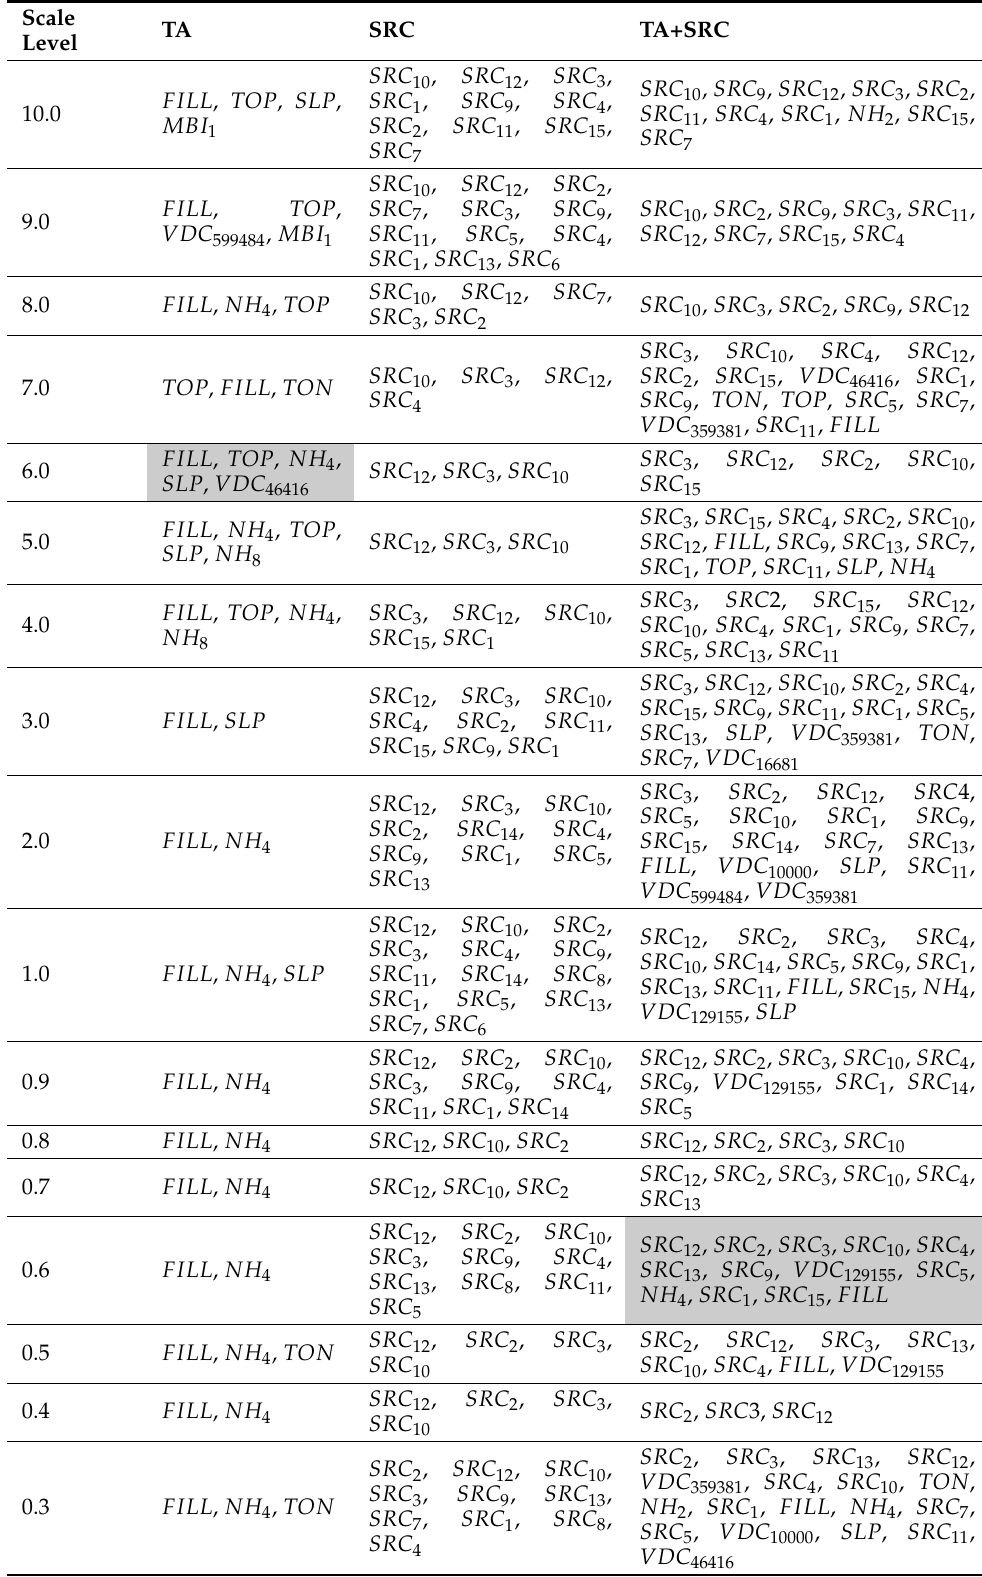
Table 4. The most important parameters based on RFE algorithm, which lead to minimal RMSE accuracy metrics. The order of the parameters represents their meaning. The gray marked table cells refer to Figure